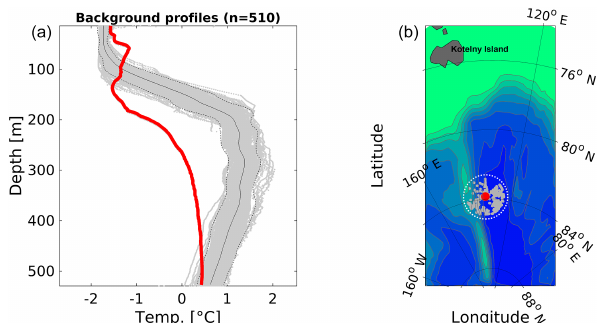
Figure 7. Sample output of the statistical screening. (a) CTD profile (red line) and 510 background profiles (grey) detected in the search window. The black solid curve is the mean temperature calculated from the background profiles, and the dashed curves are the mean ± 2 standard deviations. The geographic coordinates of the tested profile are probably wrong. (b) Location of the profile (red circle) in the Amundsen Basin and the neighboring profiles (grey circles) detected in the search